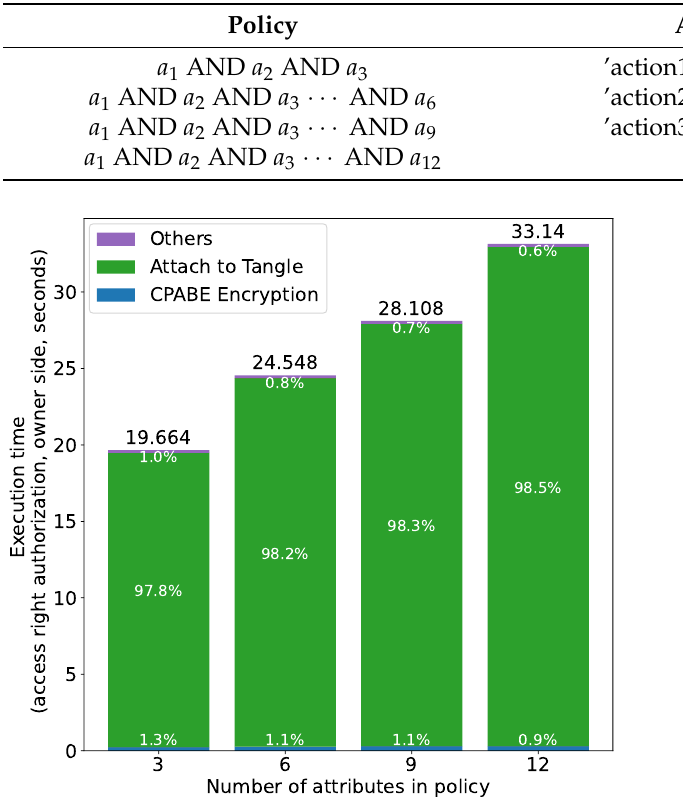
Figure 16. Access right authorization time (owner) vs. number of